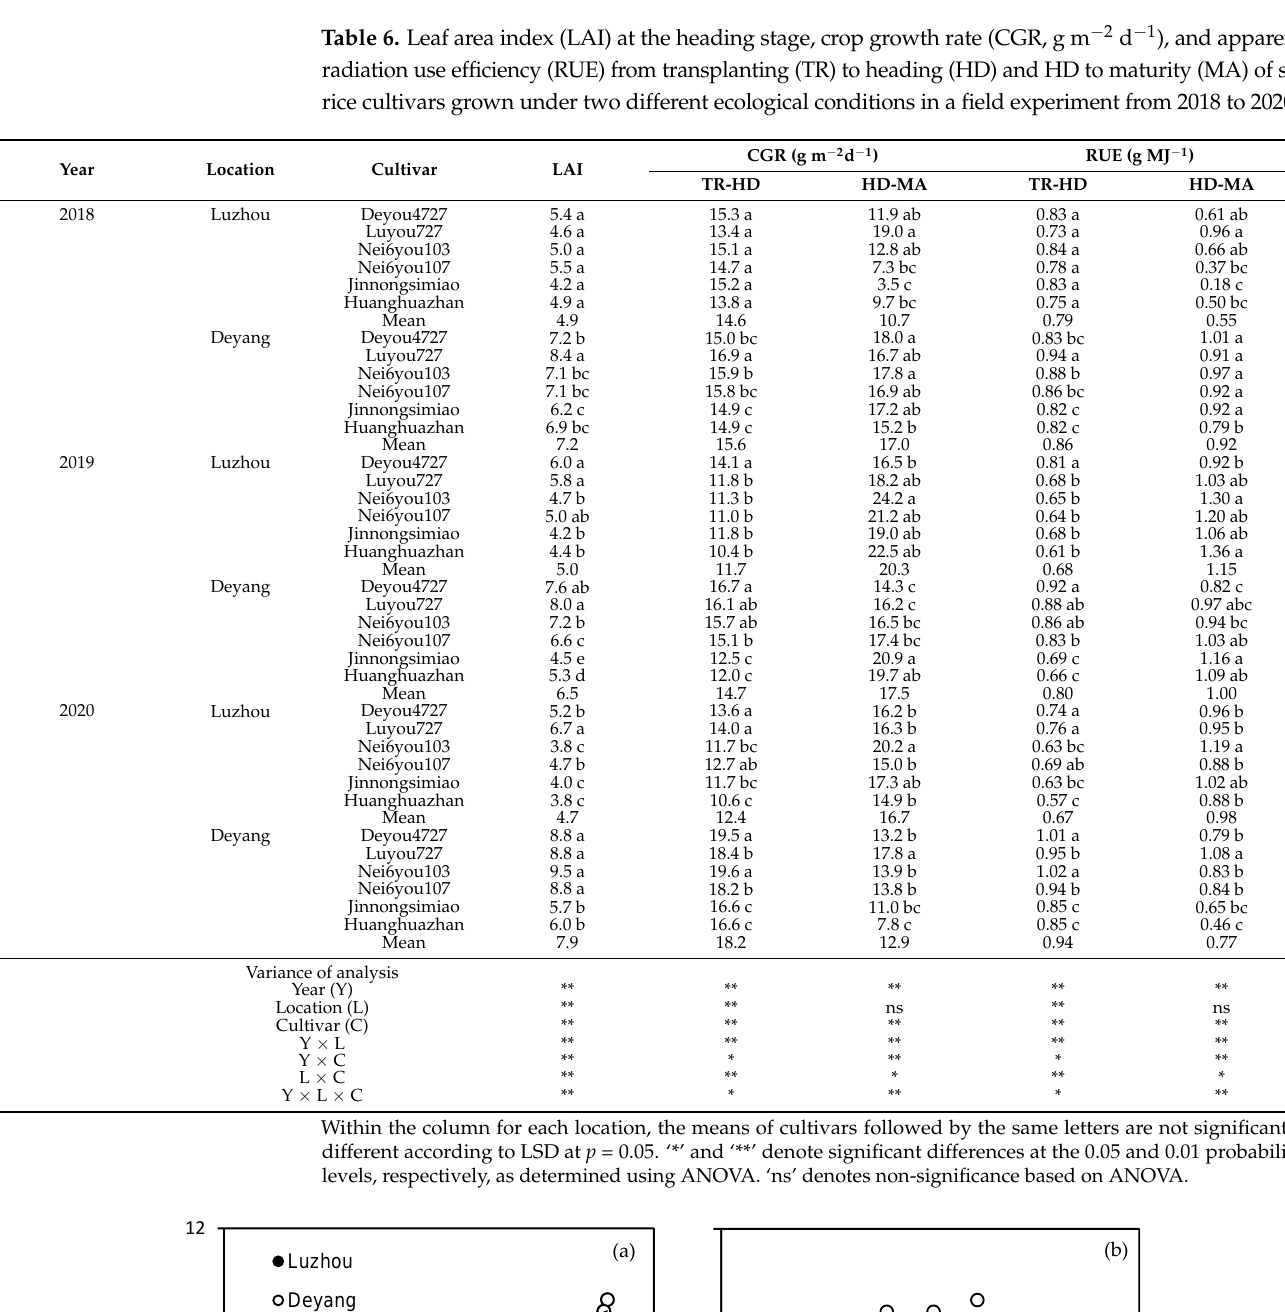
Table 6. Leaf area index (LAI) at the heading stage, crop growth rate (CGR, g m − 2 d − 1 ), and apparent radiation use efficiency (RUE) from transplanting (TR) to heading (HD) and HD to maturity (MA) of six rice cultivars grown under two different ecological conditions in a field experiment from 2018 to 2020.